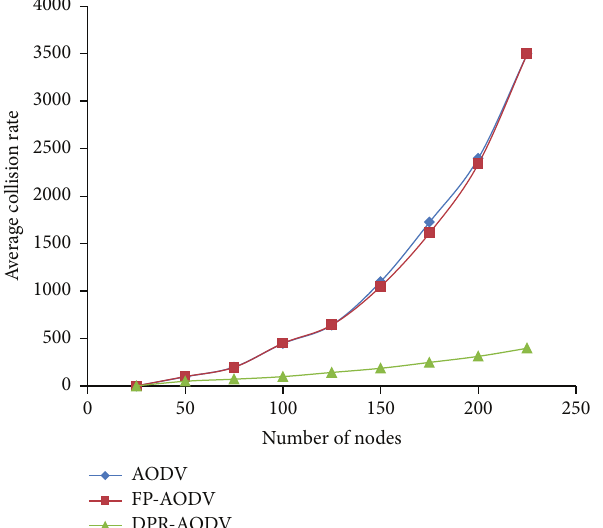
Figure 6: Success ratio on connectivity versus number of mobile nodes.